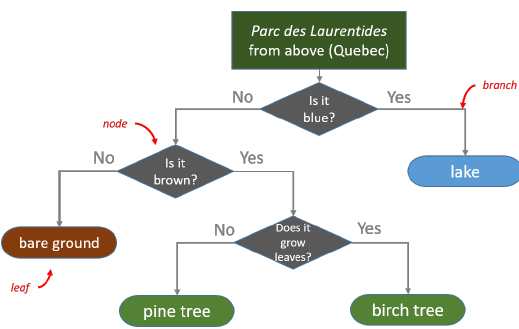
Figure 14. Example of a decision tree in a flowchart-like structure.